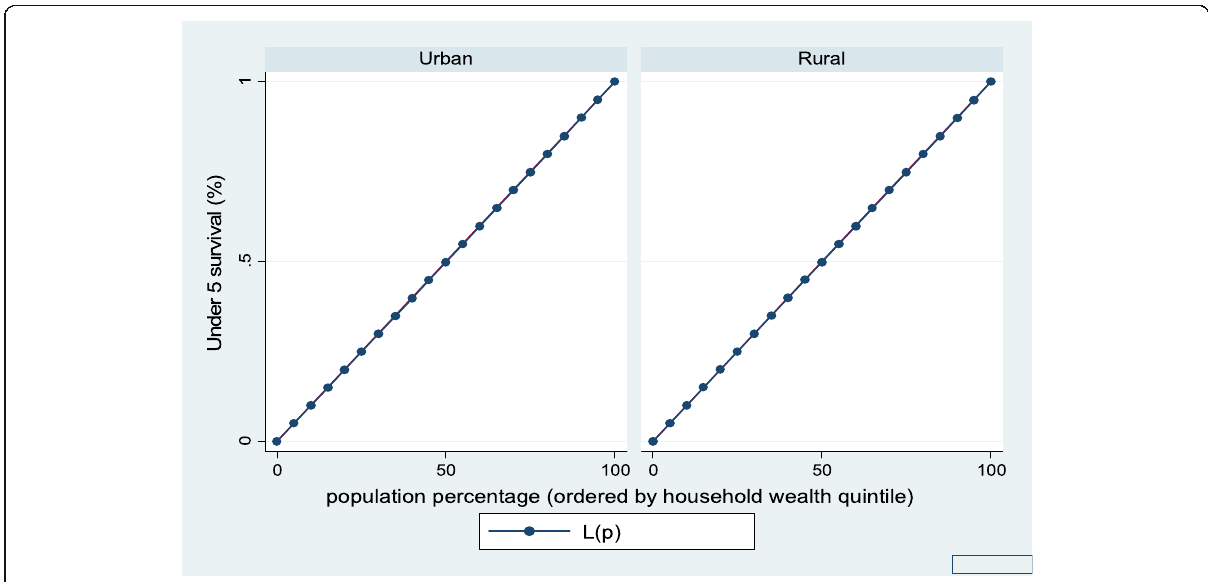
Fig. 6 Urban-rural Lorenz curve for childhood